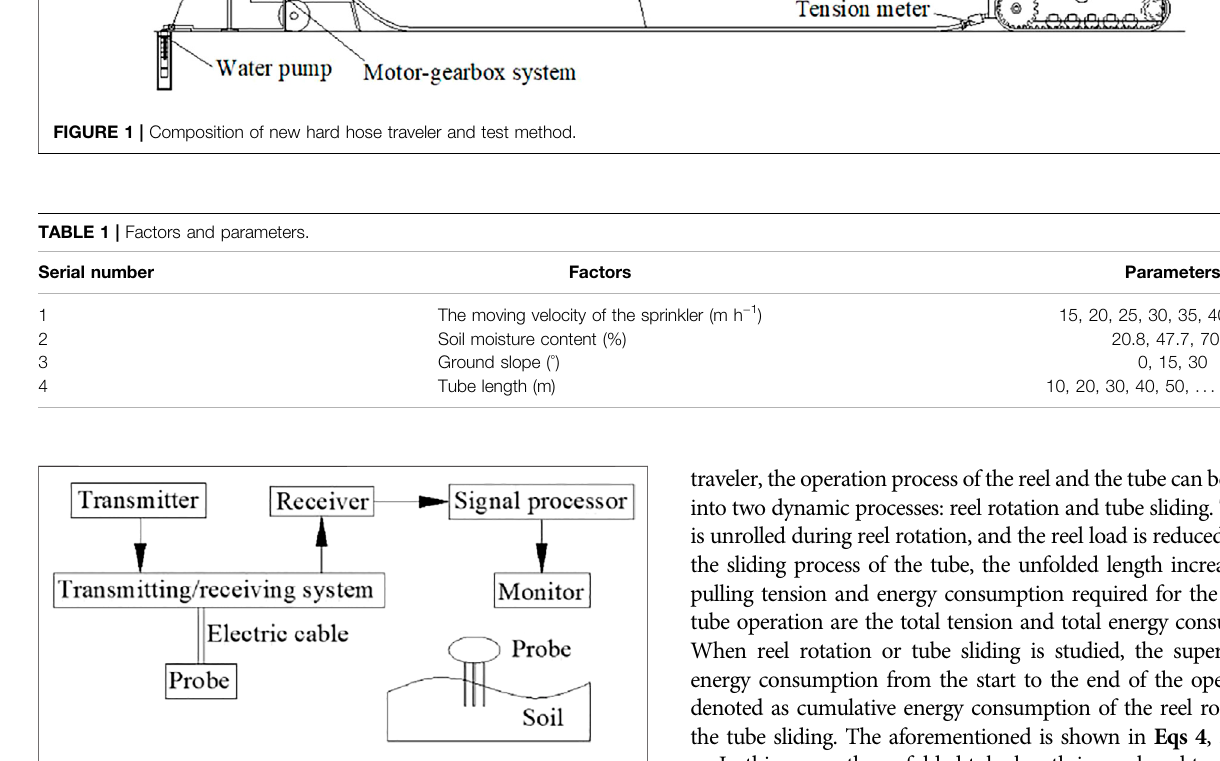
FIGURE 2 | The operating principle and Time-domain re fl ectometry